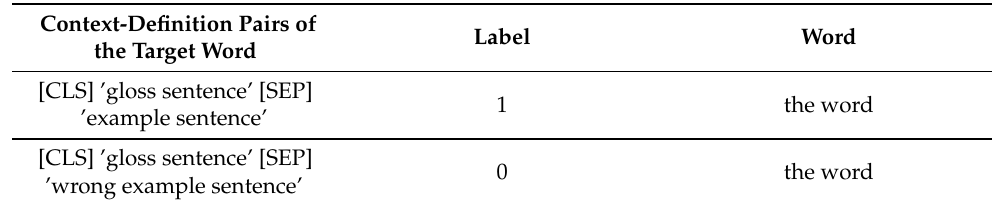
Table 5. Model II training data.